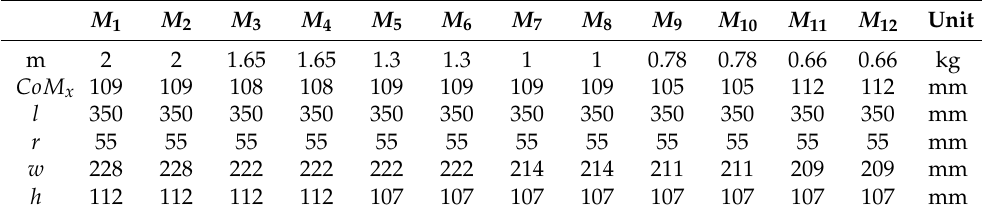
Table 2. Robotic arm parameters for SLIM.